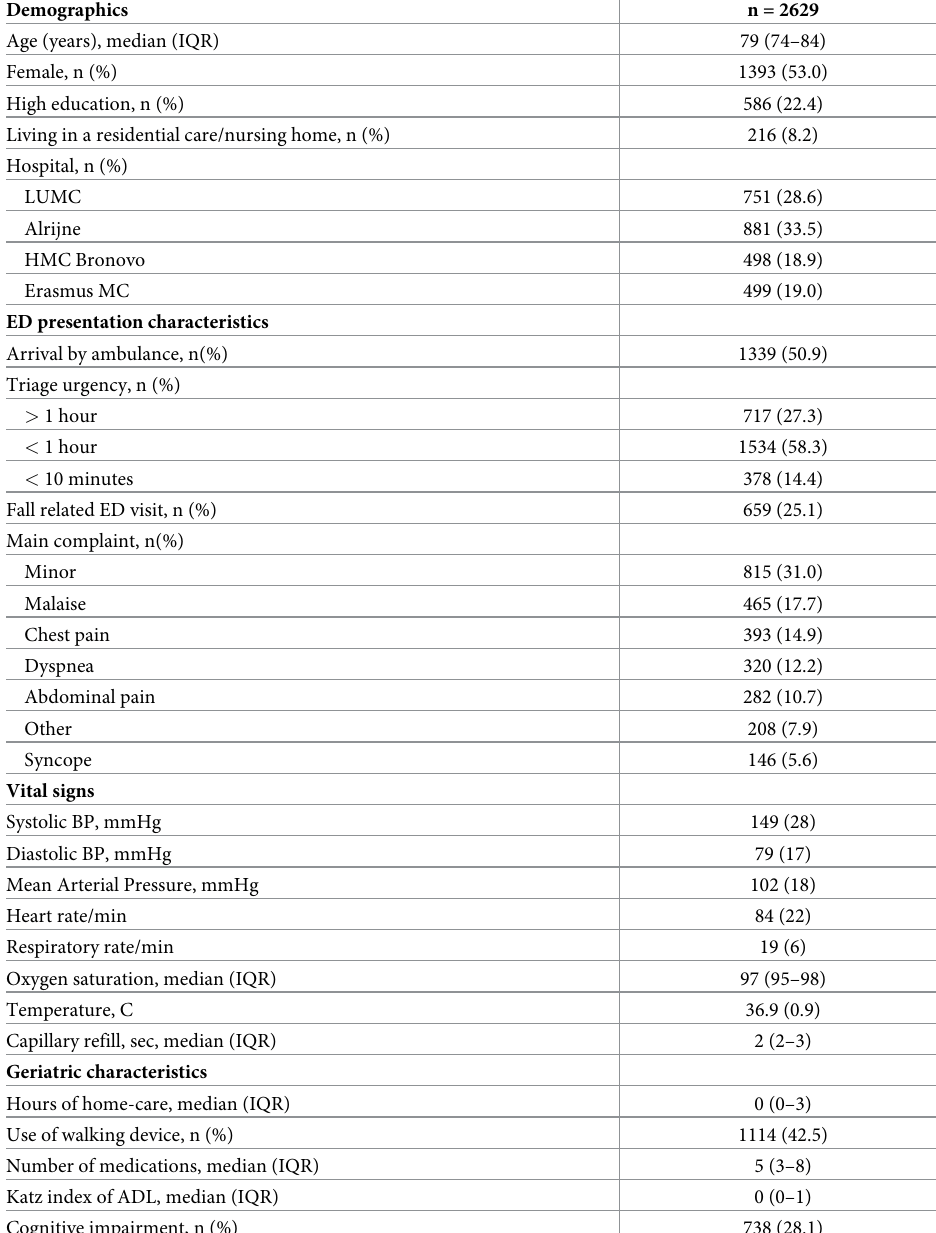
Table 1. Patients characteristics of study